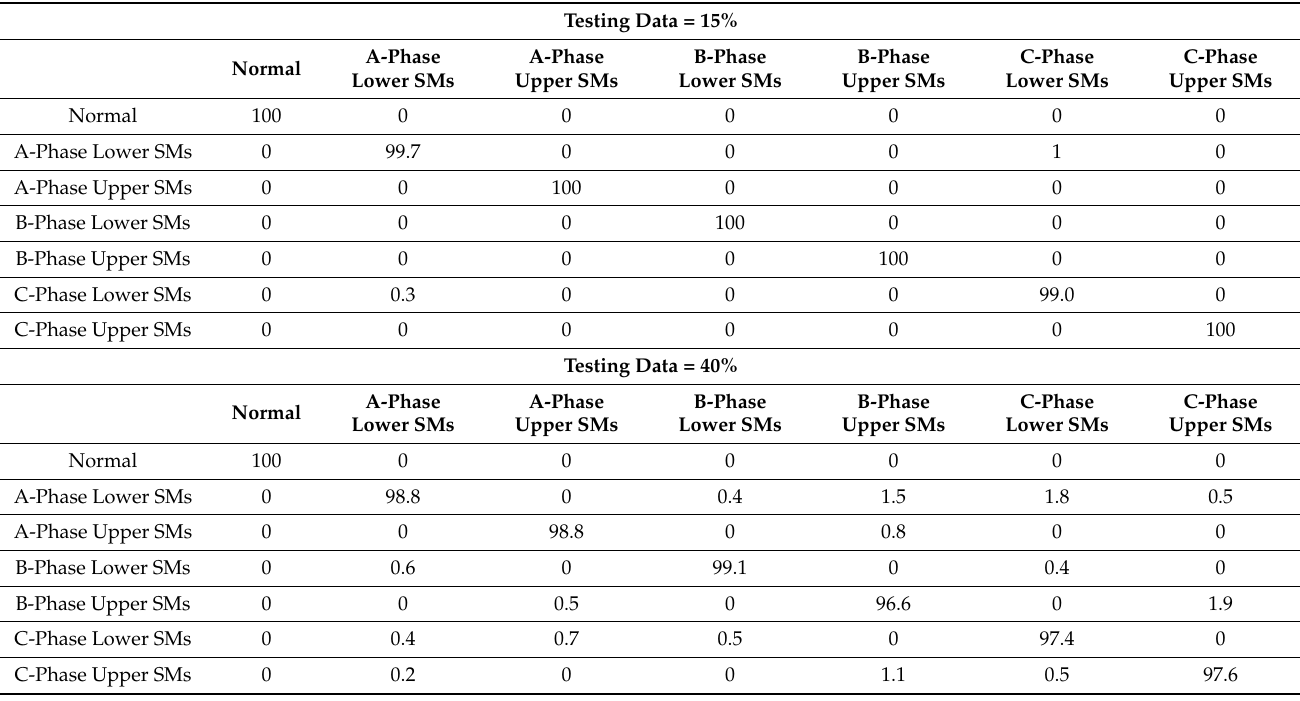
Table 4. Sample confusion matrix of the classification results of SVM-based ECOC without data normalization.